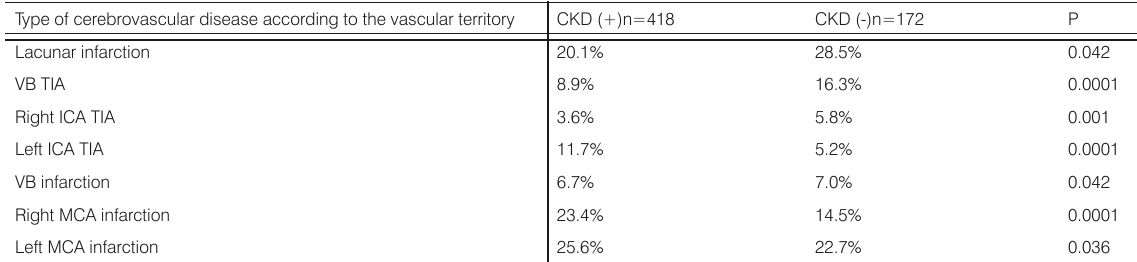
Chi-square test. All reported P values are two-sided. ECD- extracranial Doppler ultrasound, TCD- transcranial Doppler ultrasound, CKD- chronic kidney disease, CA- carotid artery, MCA-middle cerebral artery. Table 3. Types of ischaemic cerebrovascular disease in relationship with the vascular territories in CKD(+) and CKD(-) patients.